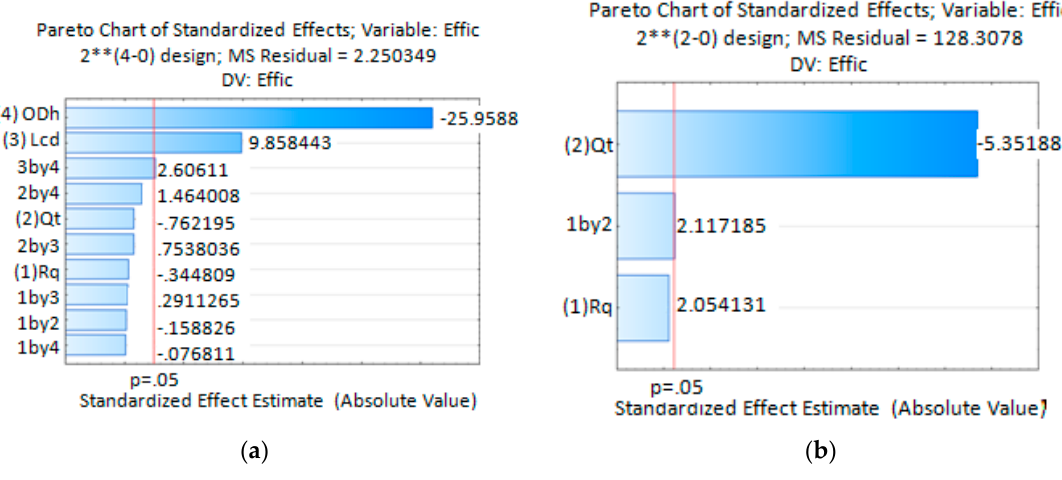
Figure 12. Statistical analysis results, Pareto Chart of Standardized Effects for the extraction efficiency ( a ) For simulation experiences; ( b ) For experiments done with microfluidic device with OD H = 214.63 μ m and L CD = 21.4 mm. OD H = 214.63 µ m and L CD = 21.4